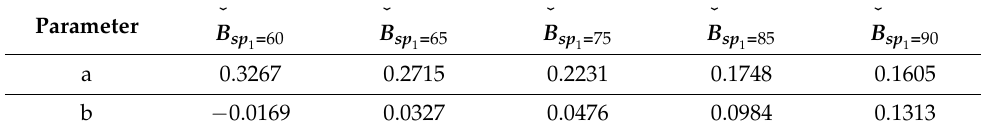
parameters’ values (procedure 1). 1